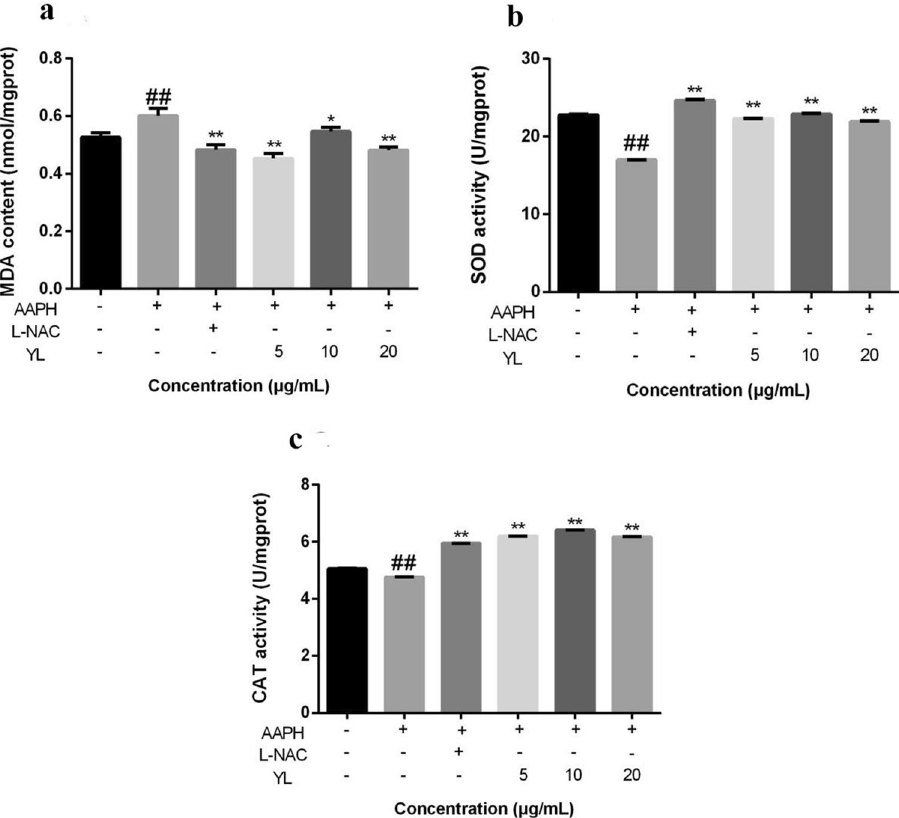
Figure 9. Effects of YL-thyme oil on levels of MDA and antioxidant enzymes activity in AAPH-induced zebrafish larvae. MDA level ( a ), SOD activity ( b ) and CAT activity ( c ) were examined after incubation. The values are expressed as mean ± SD ( n = 3). * Represents p -value less than 0.05 and ** represents p -value less than 0.01 vs. AAPH-induced group; # represents p -value less than 0.05 and ## represents p value less than 0.01 vs. control